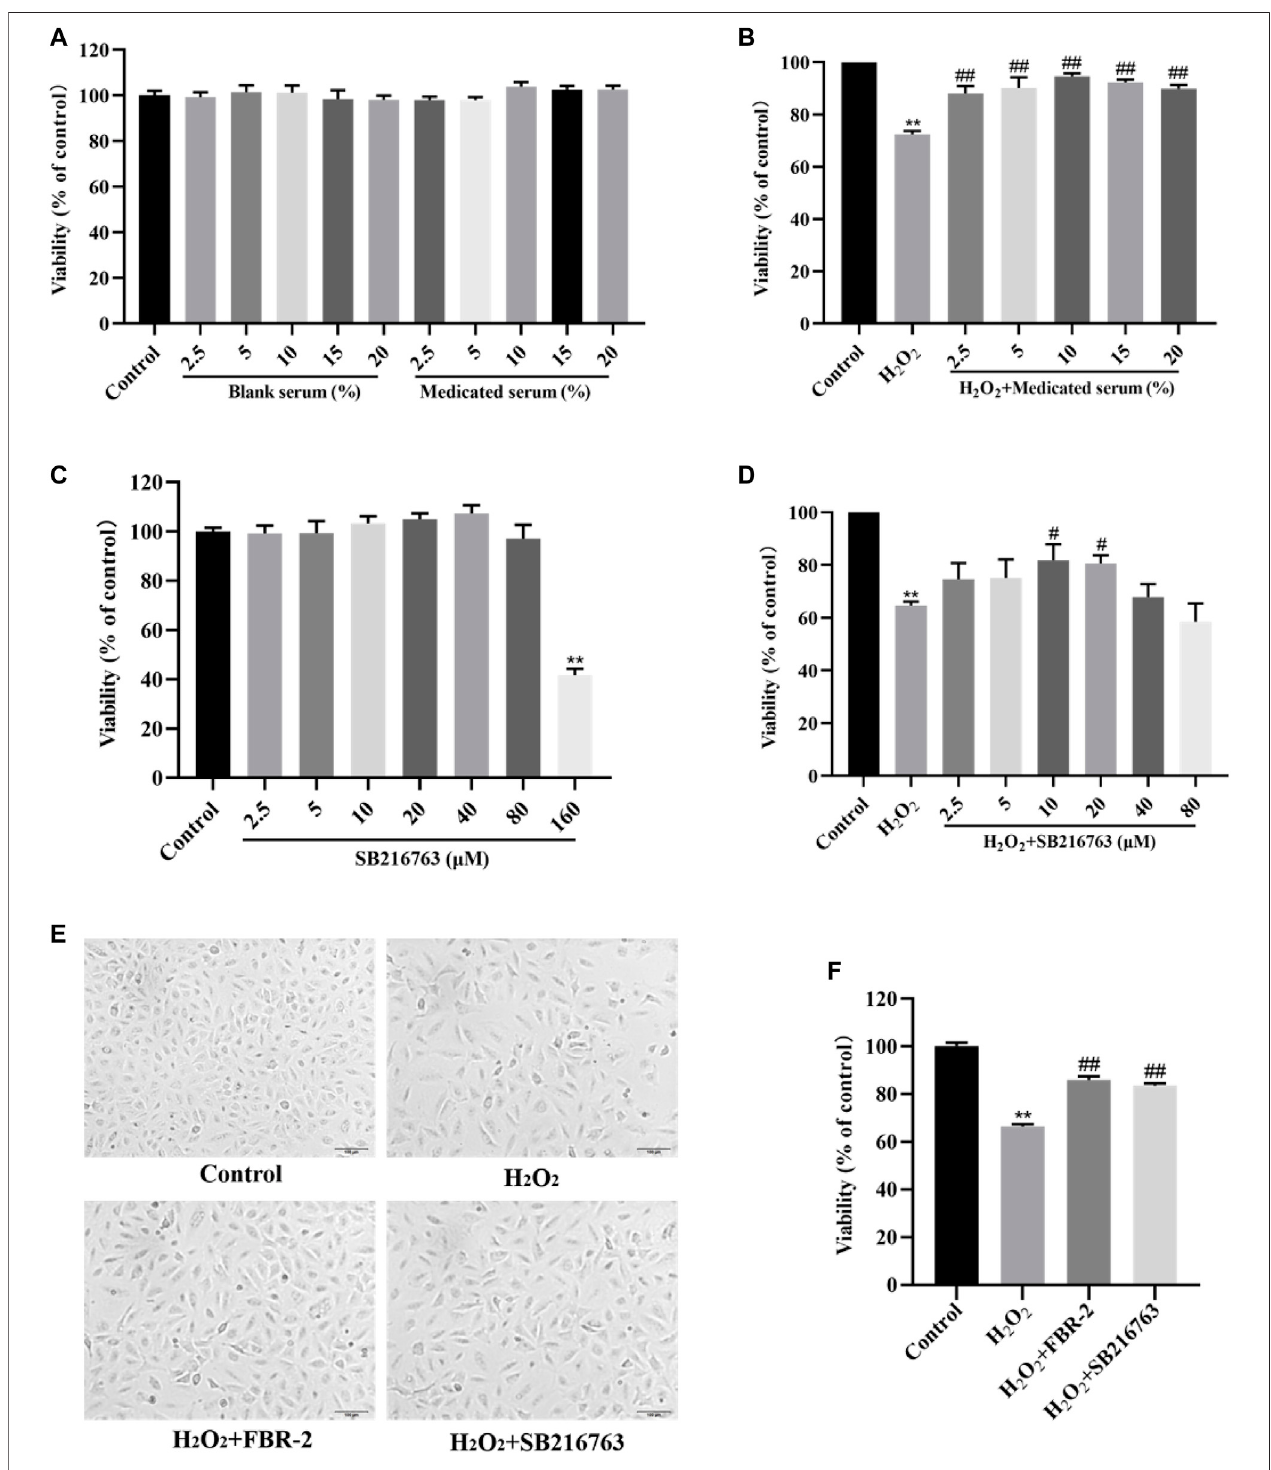
FIGURE2| FBR-2protectsA549cellsfromoxidativestressdamage. (A) TheeffectsofblankserumandFBR-2-medicated serumontheviabilityofA549cells( n = 6). (B) TheeffectofFBR-2-medicatedserumontheviabilityofA549cellsinducedbyH 2 O 2 ( n =6). (C) TheeffectofSB216763ontheviabilityofA549cells( n =6). (D) The effectofSB216763ontheviabilityofA549cellsinducedbyH 2 O 2 ( n =6). (E) TheeffectofFBR-2-medicatedserumonthemorphologyofA549cellsinducedbyH 2 O 2 . (F) The protective effect of FBR-2 on A549 cells induced by H 2 O 2 ( n = 6). ** p < 0.01, compared with the control group; # p < 0.05 and # # p < 0.01, compared with the H 2 O 2